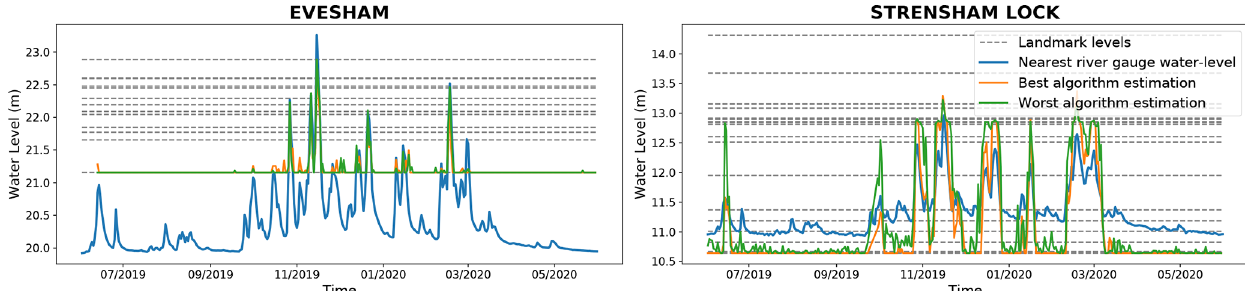
Figure 8. Evesham and Strensham Lock year-long water levels measured using landmark annotations in comparison with water levels from nearby river gauges. The best networks are DeepLab-WATERDB-WHOLE for Evesham and Strensham. The worst networks are RU-LAGO- WHOLE for Evesham and RU-LAGO-2STEPS for